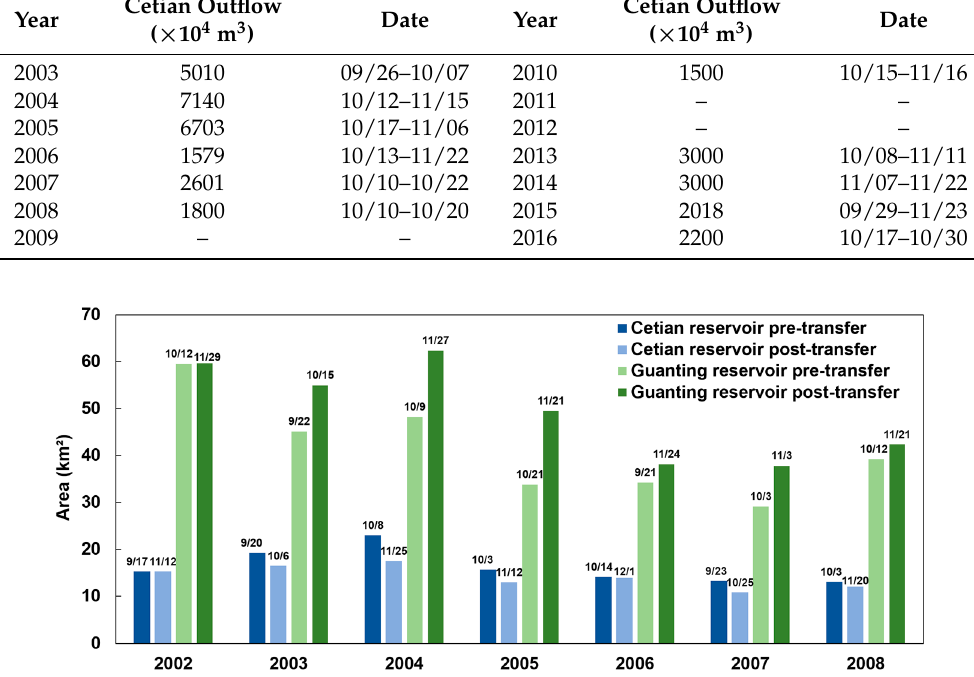
Table 6. The outflow and dates of water delivery from Cetian reservoir to Guanting reservoir.